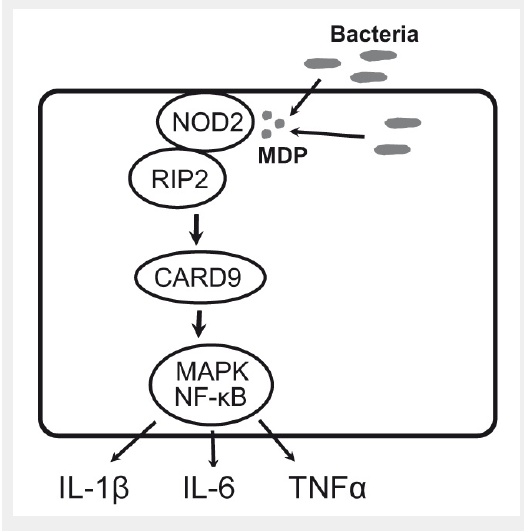
Figure 1 Innate immune activation through NOD2. Muramyl dipeptide (MDP) present in the cell wall of Gram positive and Gram negative bacteria activates the intracellular sensor NOD2 (CARD15), which interacts through CARD-CARD binding with RICK/RIP2 (CARD3) and with CARD9. Activation of several other adaptor proteins leads to activation of NF-κB and mitogen activated protein kinases (MAPK; JNK, p38, ERK) and secretion of proinflammatory